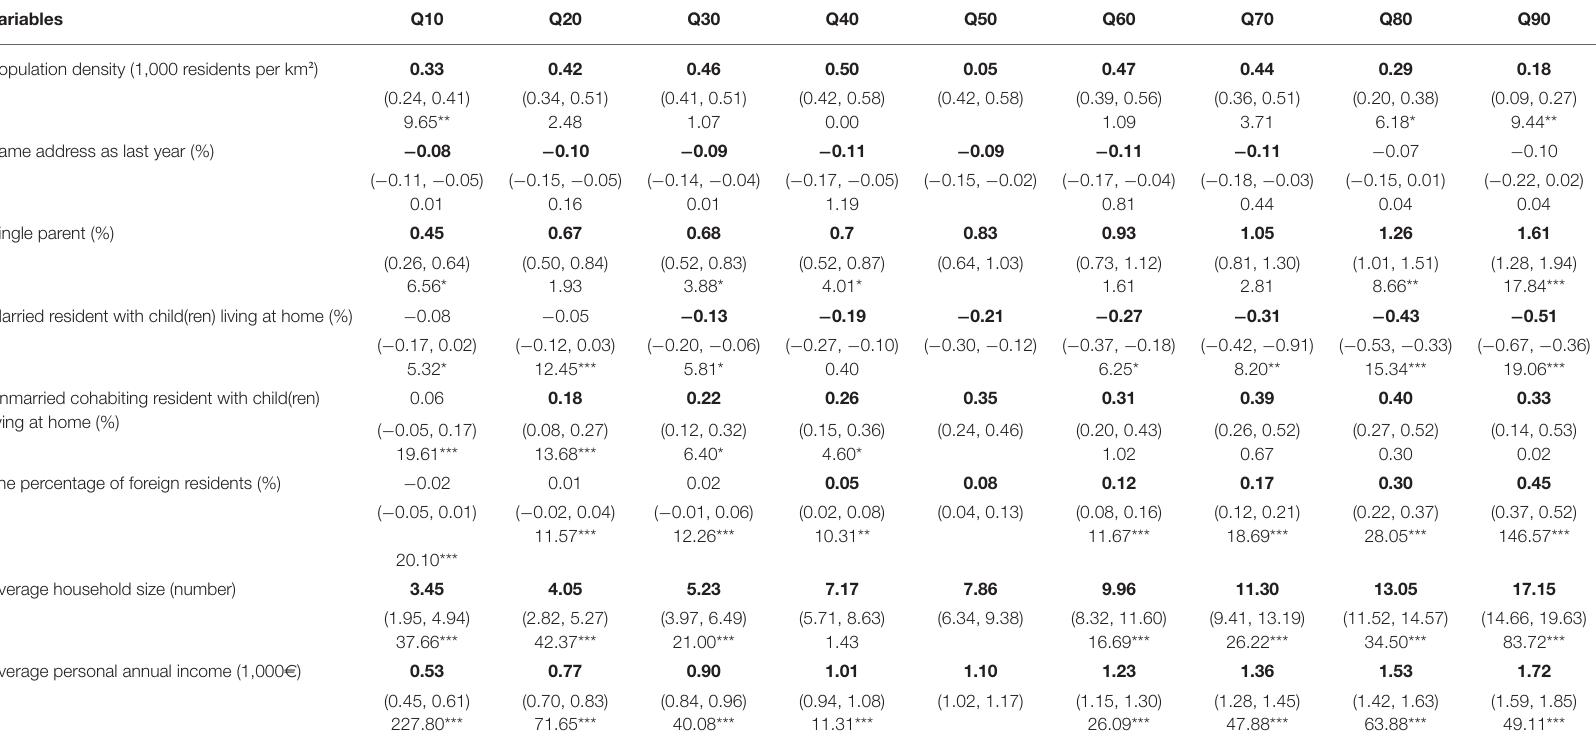
TABLE 4 | Multivariable quantile regression coefficient and 95%CI of the determinants of coverage of the opportunistic screening at the 10th (Q10) to the 90th (Q90) quantiles. Variables Q10 Q20 Q30 Q40 Q50 Q60 Q70 Q80